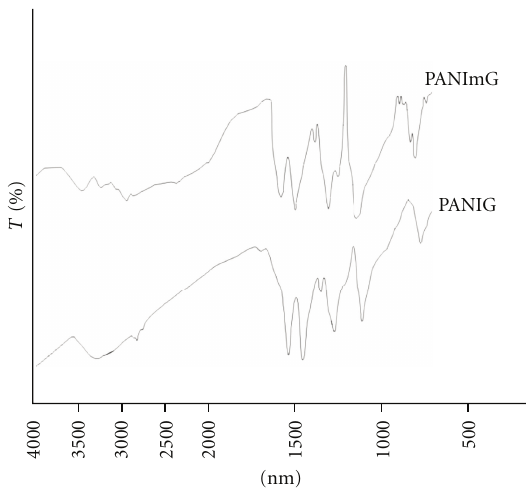
Figure 1: FT-IR spectra of PANIG and PANImG.